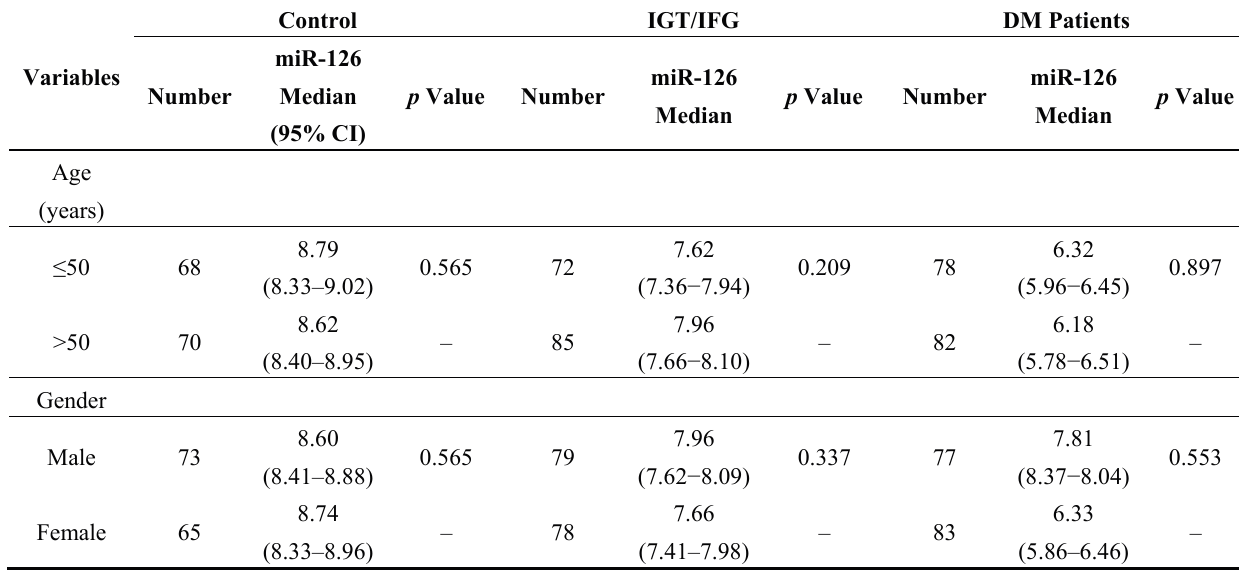
Table 2. The distribution of serum miR-126 in different groups.